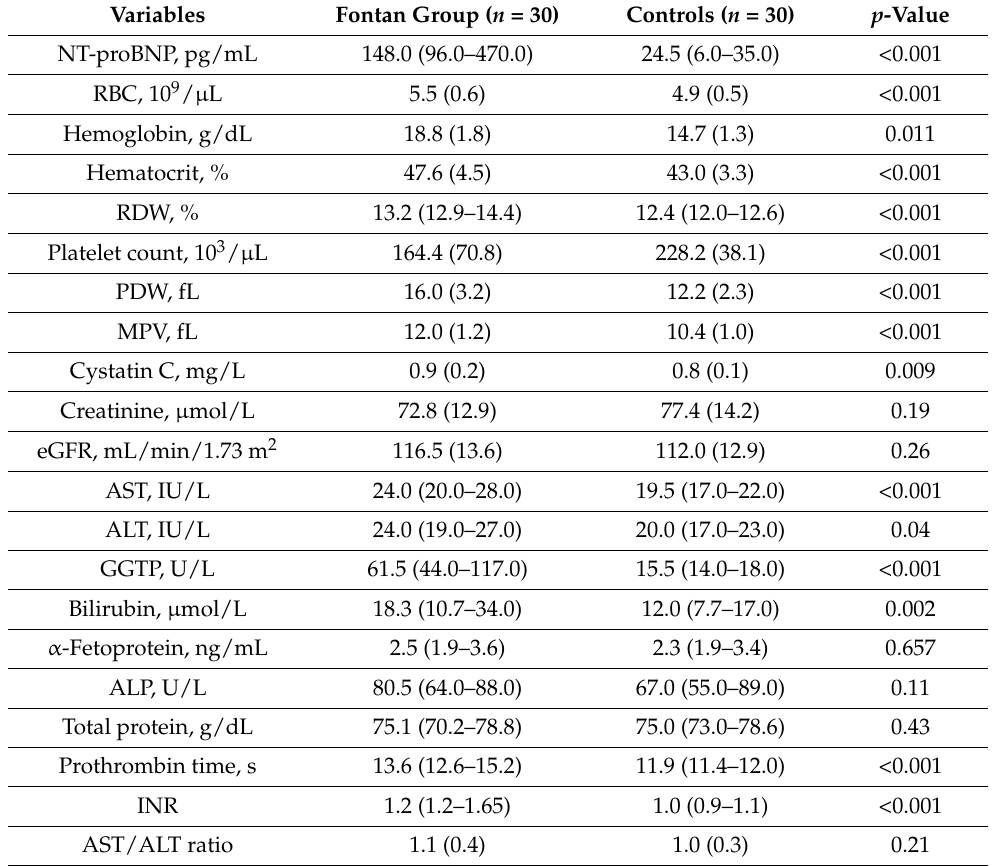
Table 3. Laboratory parameters in patients after Fontan procedure and in